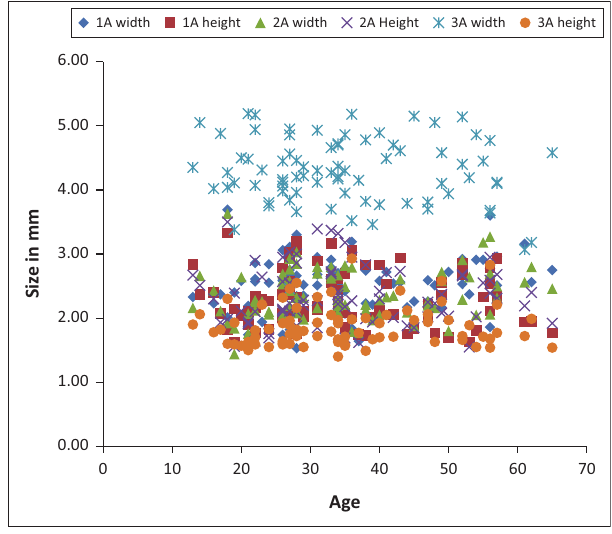
FIGURE 4: Overall age distribution of optic nerve measurements. No age correlation was demonstrated. The correlation coefficient varied from -0.14 to 0.19.